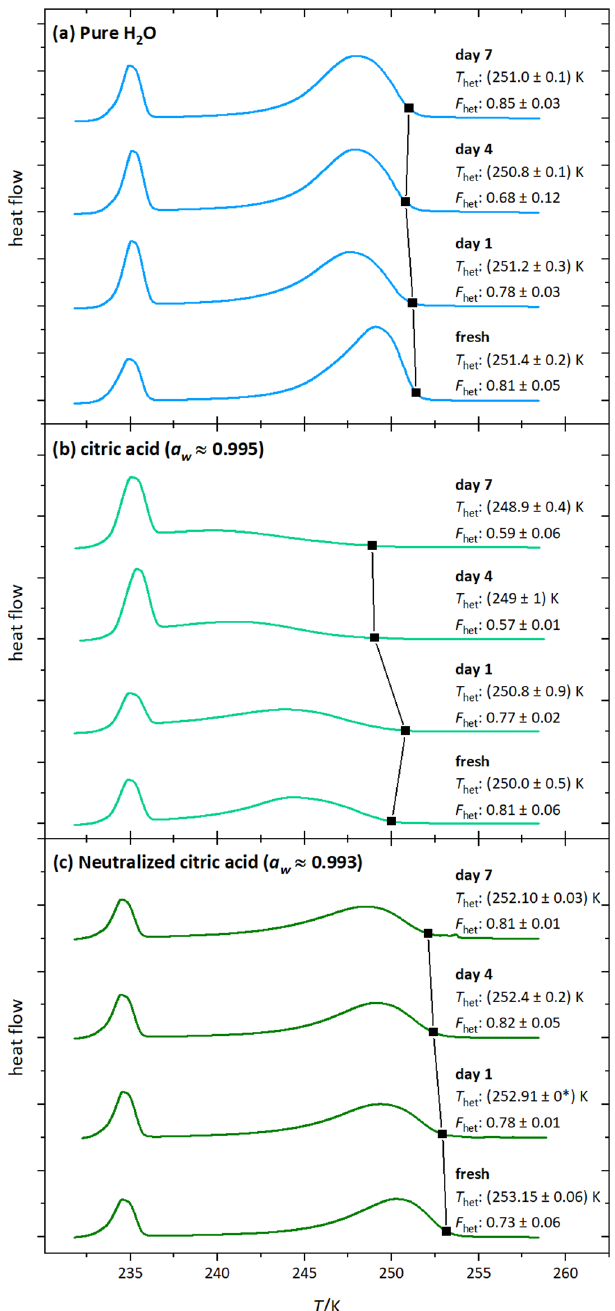
Figure 5. DSC thermograms of microcline (2wt%) in (a) wa- ter, (b) 1wt% citric acid ( a w ≈ 0 . 995), and (c) 1wt% citric acid neutralized with NH 3 ( a w ≈ 0 . 993) measured directly after the preparation (fresh) and on the displayed days (days 1, 4, 7). Black squares mark the heterogeneous freezing onset temperatures. The thermograms are normalized with respect to their total integral. The displayed T het and F het values and the black squares are the aver- age of two measurements. The corresponding uncertainties are the standard deviation (black star label: both measurements yielded the same T het